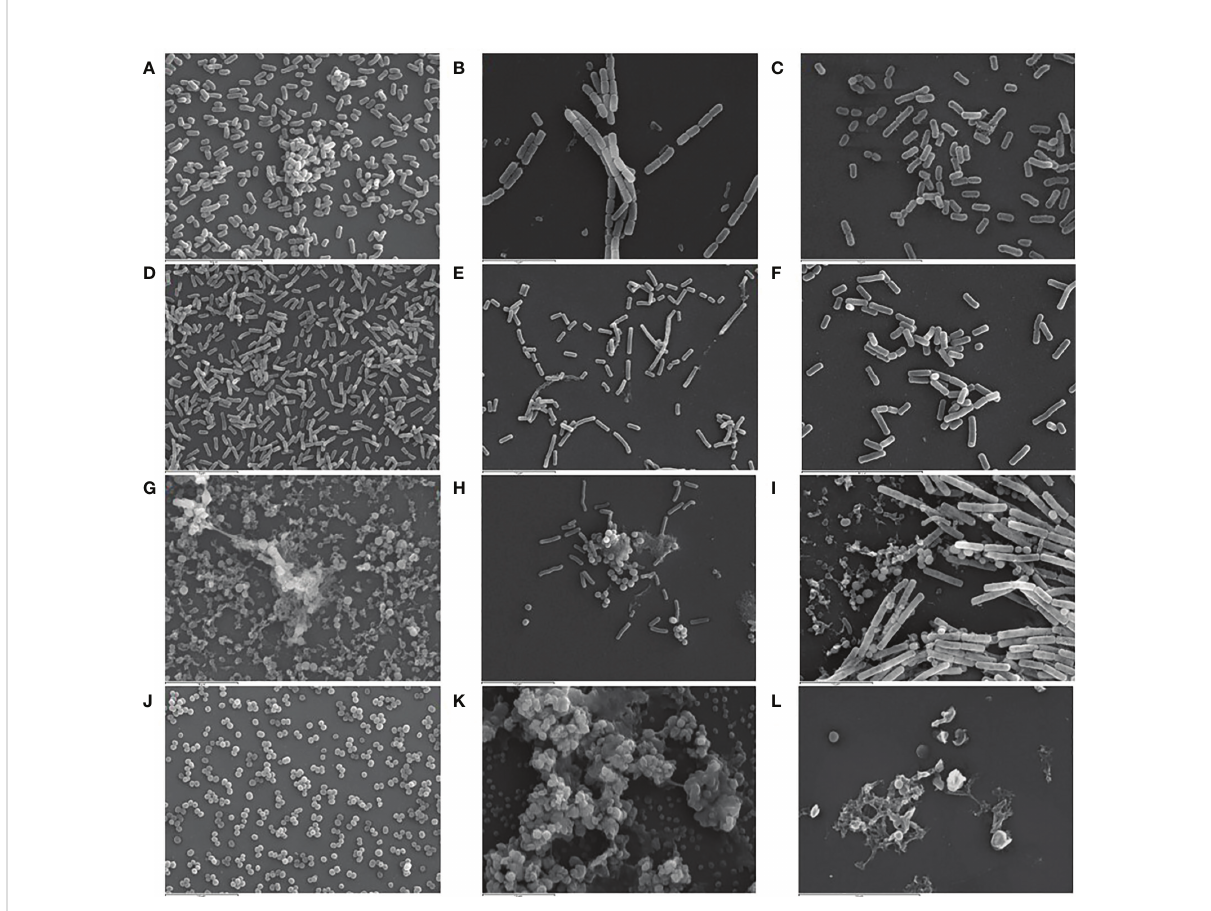
FIGURE 5 Representative SEM images (3,000×) of monospecies bio fi lms (48 h) of K. pneumoniae 9SNG3 (A) , S. marcescens 10SNG3 (D) , S. aureus 45SNG3 (G) and S. epidermidis 46SNG3 (J) . Representative SEM images of dual-species bio fi lms of K. pneumoniae 9SNG3 (B) , S. marcescens 10SNG3 (E) , S. aureus 45SNG3 (H) and S. epidermidis 46SNG3 (K) with L. reuteri 7SNG3. Representative SEM images of dual-species bio fi lms of K. pneumoniae 9SNG3 (C) , S. marcescens 10SNG3 (F) , S. aureus 45SNG3 (I) and S. epidermidis 46SNG3 (L) with L. salivarius